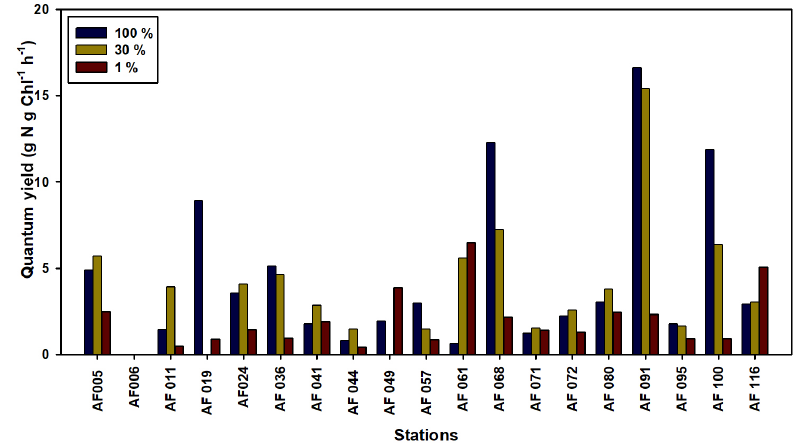
Figure 9. Quantum nitrogen yield of small phytoplankton in the sampling